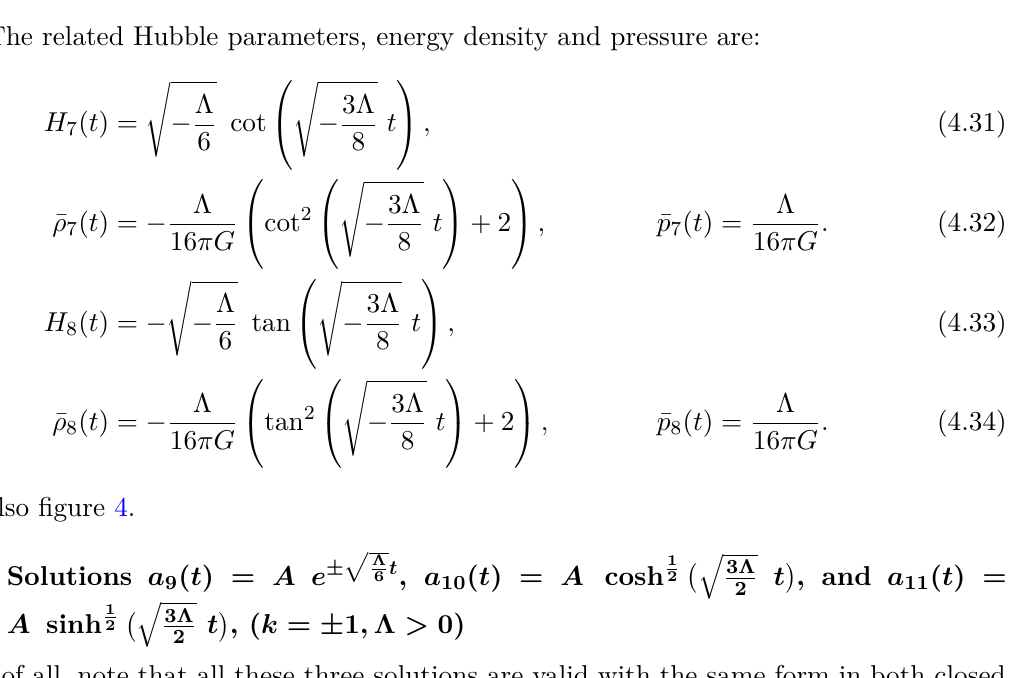
(cid:0)q (cid:0)q (cid:1) , (red) and (cid:1) , (blue) are − 3Λ t a 8 ( t ) = A cos 2 3 − 3Λ t 8 8 ( t ) and H ( t ) are on the right 7 8